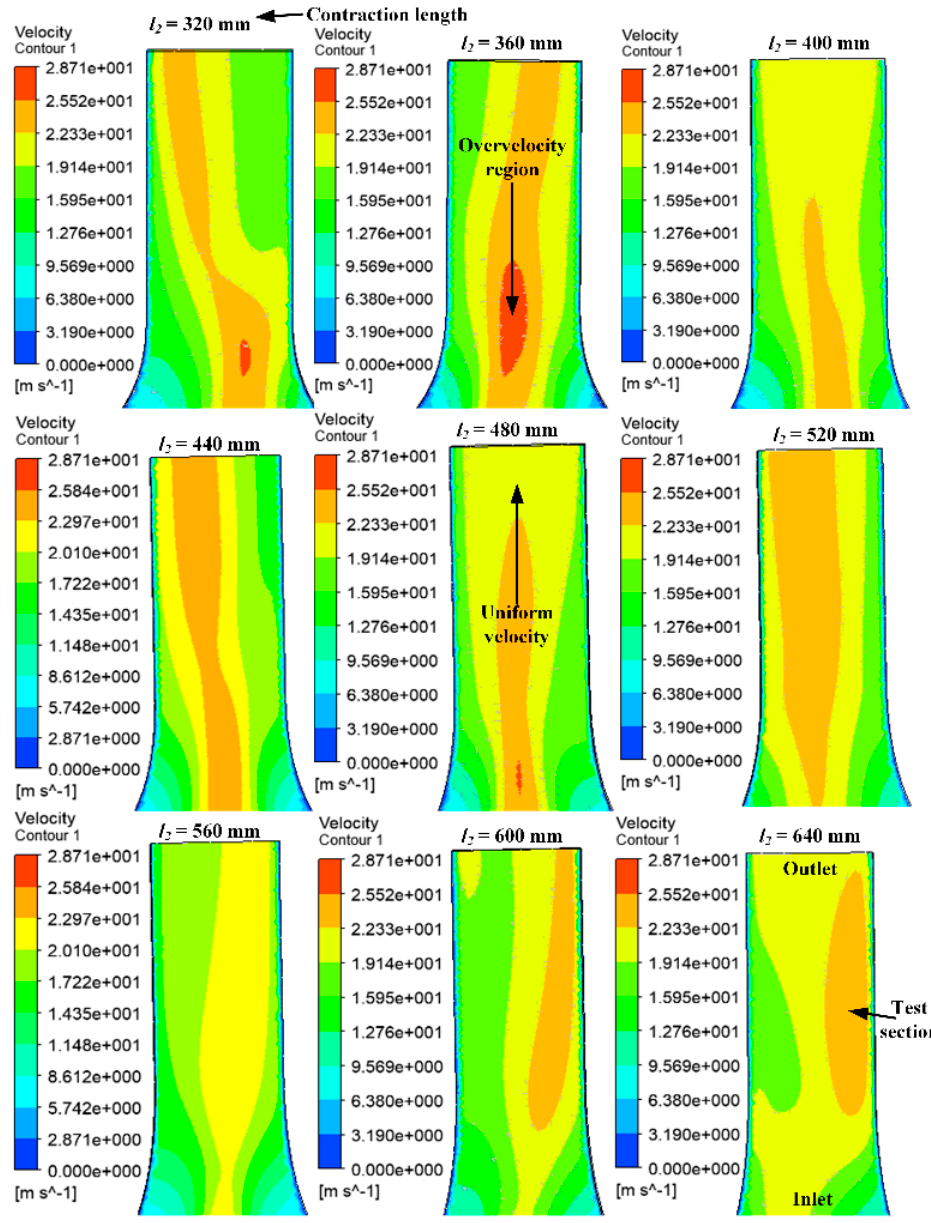
Figure 6. Velocity contour at various contraction lengths.